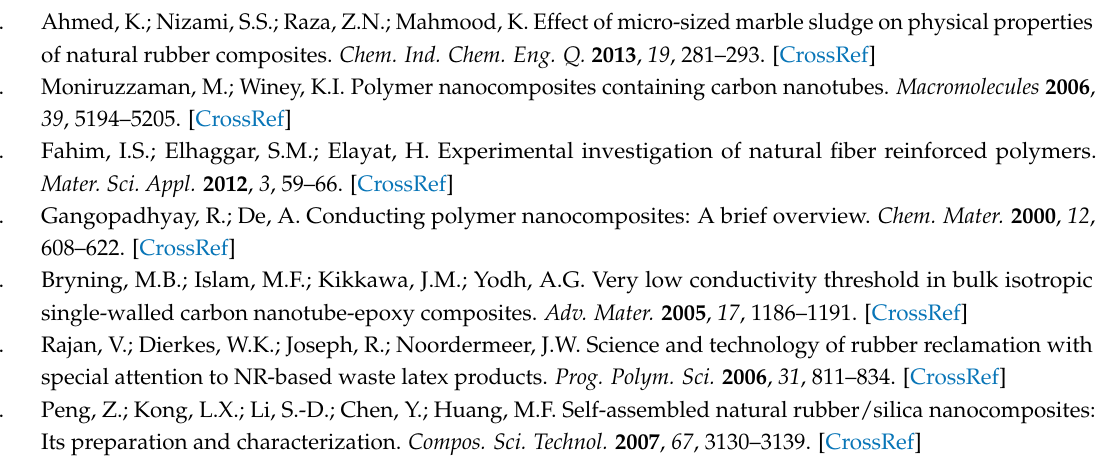
Figure S1: (a) Raman spectrum; (B) X-ray diffraction XRD pattern and (C) Thermogravimetric analysis TGA spectrum of graphene nanoplatelets; Figure S2: SEM images of the graphene nanoplates@natural rubber latex composite; Figure S3: Differential scanning calorimetry (DSC) spectrum of the natural rubber and GNPs/rubber composite. Differential scanning calorimetry (purple line) and scanning calorimetry (blue line); Figure